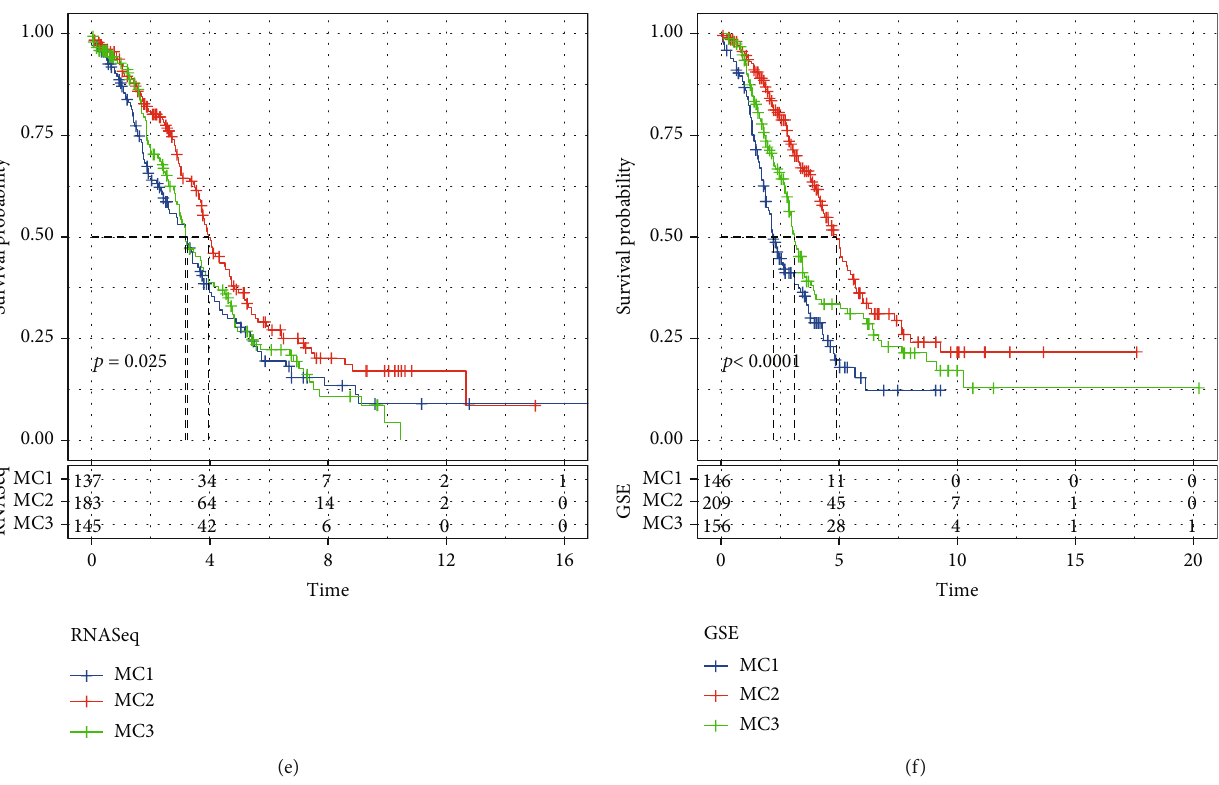
Figure 2: Metabolism cluster in OV. (a) Intersection Venn diagram of metabolic genes with signi fi cant prognosis in the two cohorts. (b and c) RNASeq cohort sample CDF curve and CDF delta area curve and delta area curve of consensus clustering, indicating the relative change in the area under the cumulative distribution function (CDF) curve for each category number k compared with k – 1. The horizontal axis represents category number k, and the vertical axis represents the relative change in the area under the CDF curve. (d) Consensus k = 3 . Sample clustering heat map. (e) KM curve of the prognosis of the three subtypes in the RNASeq cohort. (f) KM curve of the prognosis of the three subtypes in the GSE